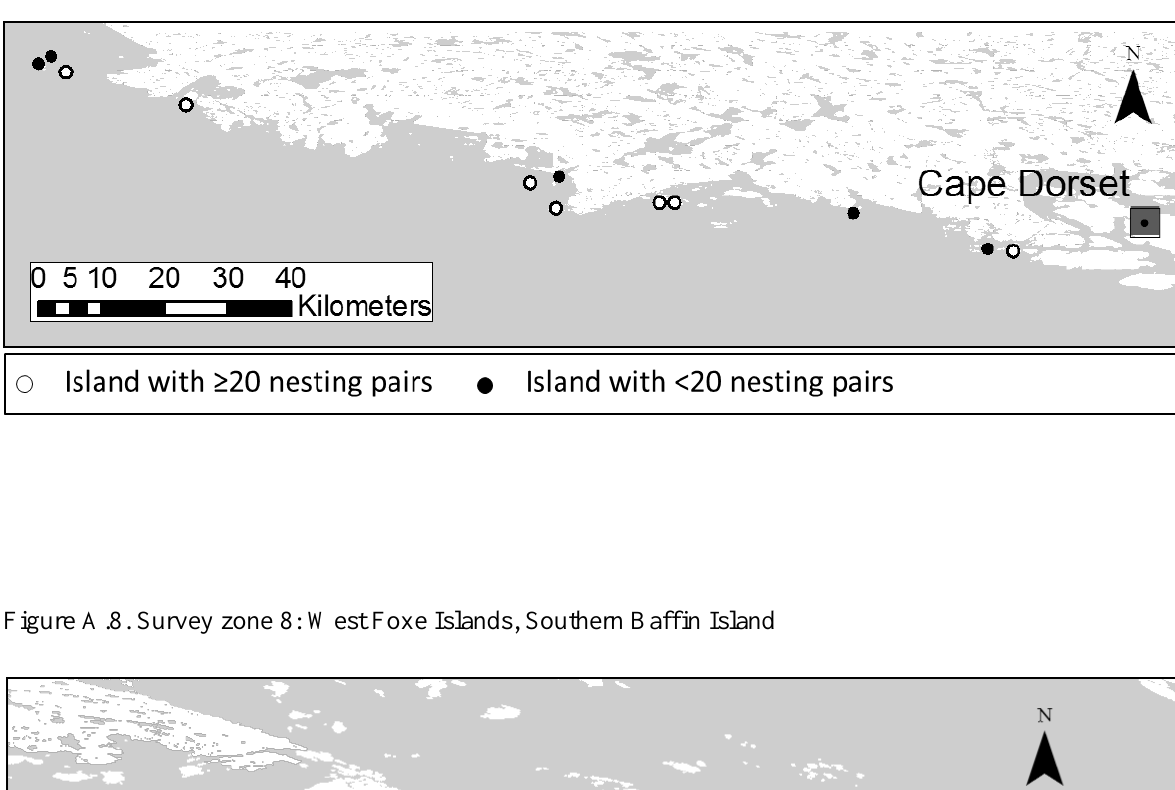
Figure A1.7. Survey zone 7: Foxe Peninsula, Southern Baffin Island